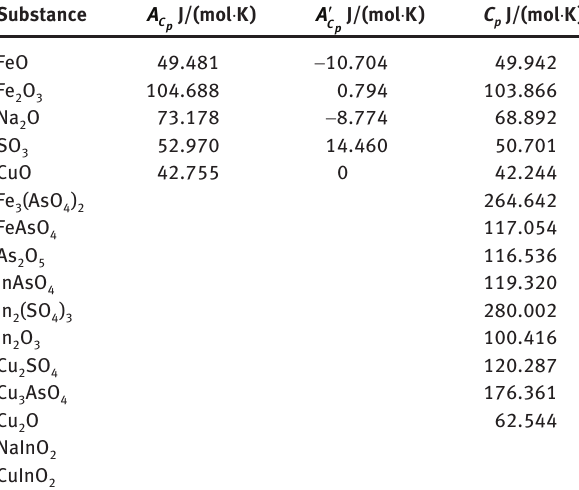
A , ′ A and C p of oxides at 298.15 K Table 3: p C p C